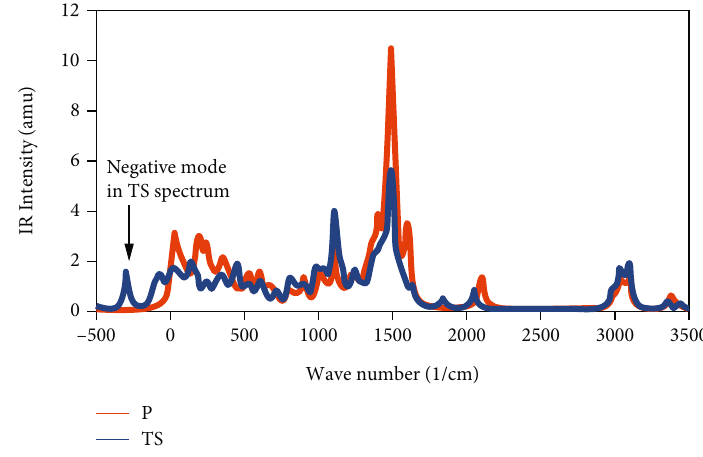
Figure 9: The calculated infrared (IR) spectrum for the P (orange line) and TS (blue